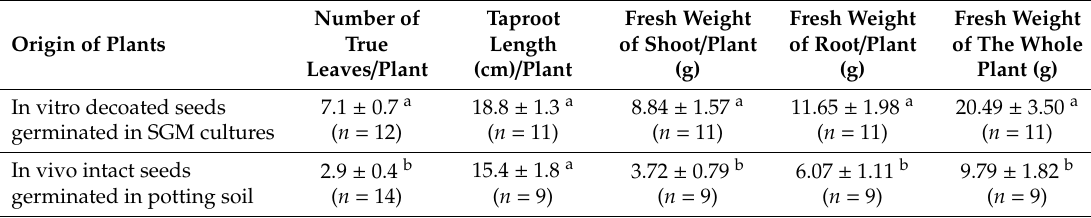
Table 5. Growth features of five months-old in vitro vs. in vivo developed M. autumnalis plants *. Number of Origin of Plants Leaves / Plant Plant (g) In vitro decoated